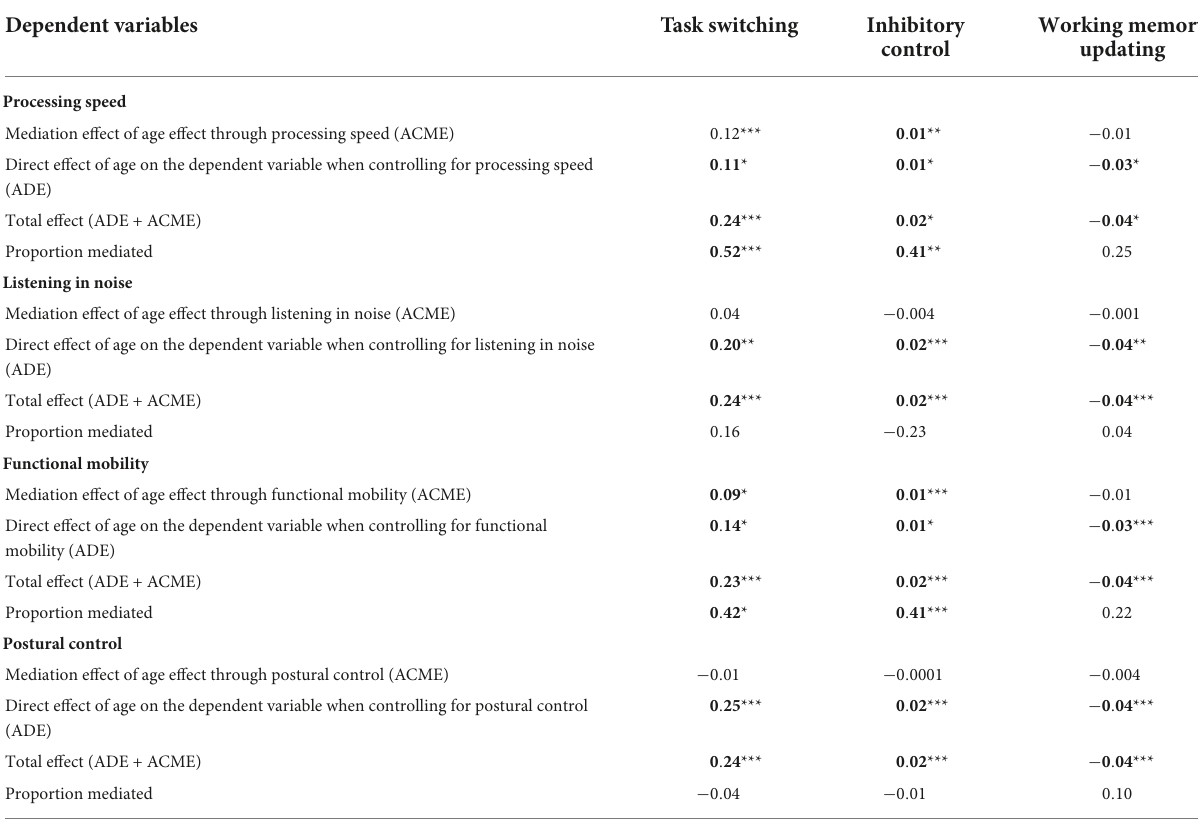
TABLE 2 Causal mediation